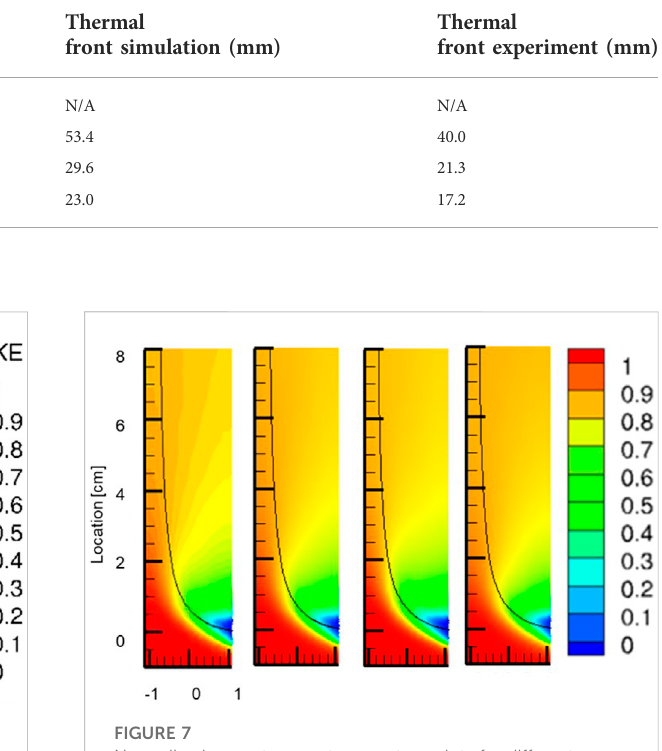
FIGURE 6 Turbulent kinetic energy (0.5 < u ′ i u ′ i > normalized by the square of velocity magnitude) contour plots for various momentum ratios (cases 1 – 4 from left to right). Jet trajectories displayed with solid black line.